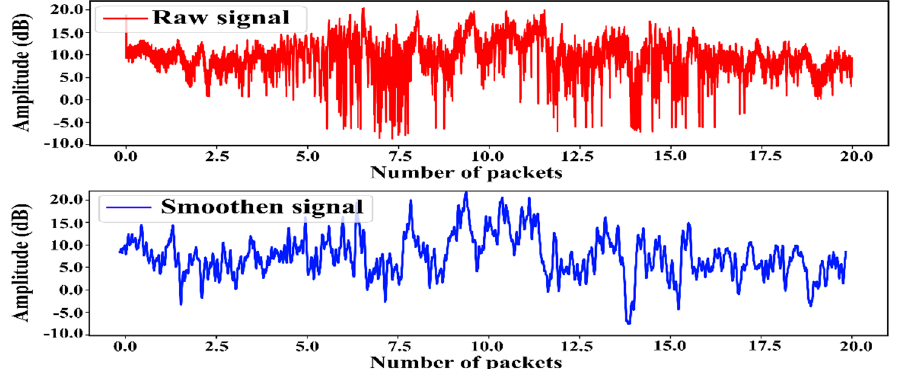
Figure 2. Visualization of the raw and smoothen CSI signal for Run activity.